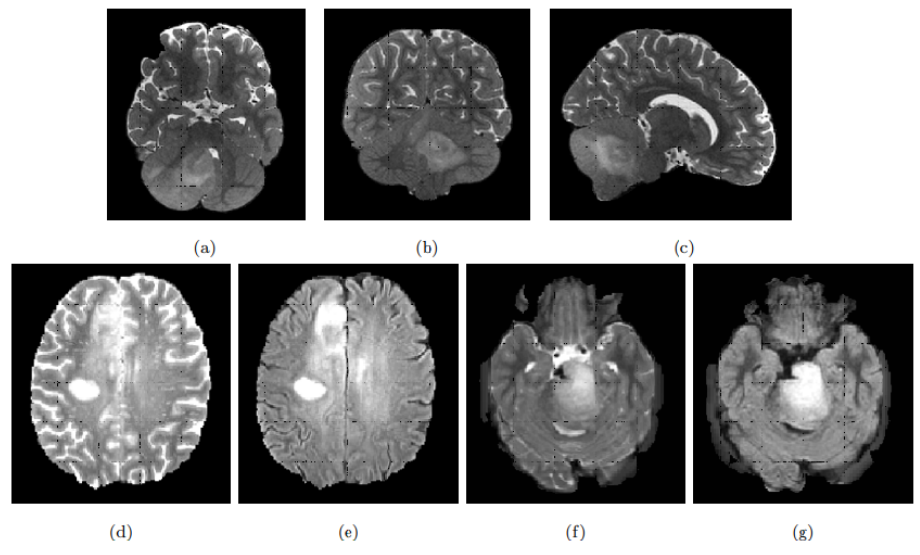
Figure 1. Top row: Example of T2w MRI scan of a patient with DIPG tumour extending beyond the pons. ( a ) Axial, ( b ) Coronal and ( c ) Sagittal slices. Bottom row: Example of glioblastoma and DIPG MRI scans, in axial slices. ( d ) glioblastoma T2w, ( e ) glioblastoma FLAIR, ( f ) DIPG T2w and ( g ) DIPG